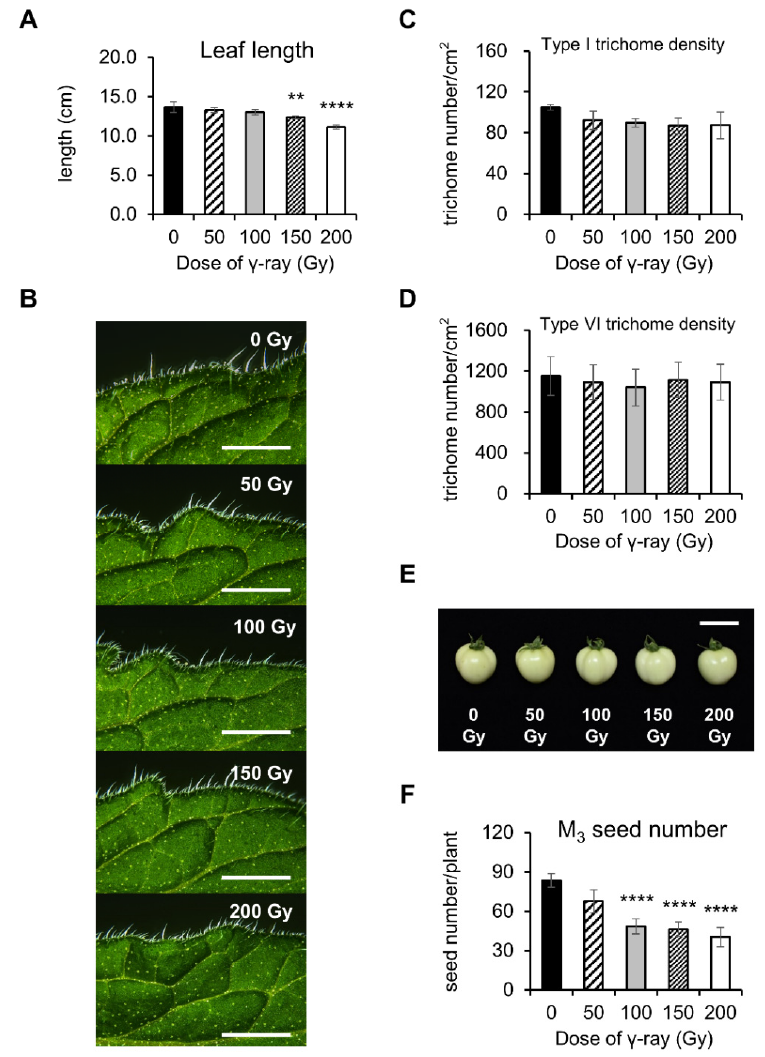
Figure 3. Effect of chronic gamma irradiation on growth and development of tomato M 2 plants. M 2 seeds harvested from the control (0 Gy) M 1 and M 1 plants irradiated with 50, 100, 150, or 200 Gy of gamma rays were germinated, grown for 7 weeks, and used. ( A ) Leaf length of control and gamma-irradiated plants. The length from the center of the plant to the edge of the largest terminal leaflet was measured. Data are presented as mean ± SE of 12 biological replicates for each dose. Asterisks represent significant differences between control and gamma-irradiated plants (unpaired t -test: ** p < 0.01; **** p < 0.0001). ( B ) Dissecting micrographs of the adaxial leaf surfaces of the control and gamma-irradiated plants. Scale bars represent 2 mm. ( C , D ) Density of type I ( C ) and VI ( D ) trichomes on the adaxial leaves of control and gamma-irradiated plants. Data are presented as mean ± SE of six biological replicates for each dose. ( E ) Shape of mature green fruit in the control and gamma-irradiated plants. Scale bar indicates 2 cm. ( F ) M 3 seed numbers of the control and gamma-irradiated M 2 plants. M 2 plants were grown for 28 weeks in a greenhouse to harvest the M 3 seeds. Data are presented as mean ± SE of 12 biological replicates for each dose. Asterisks represent significant differences between the control and gamma-irradiated plants (unpaired t -test: **** p <